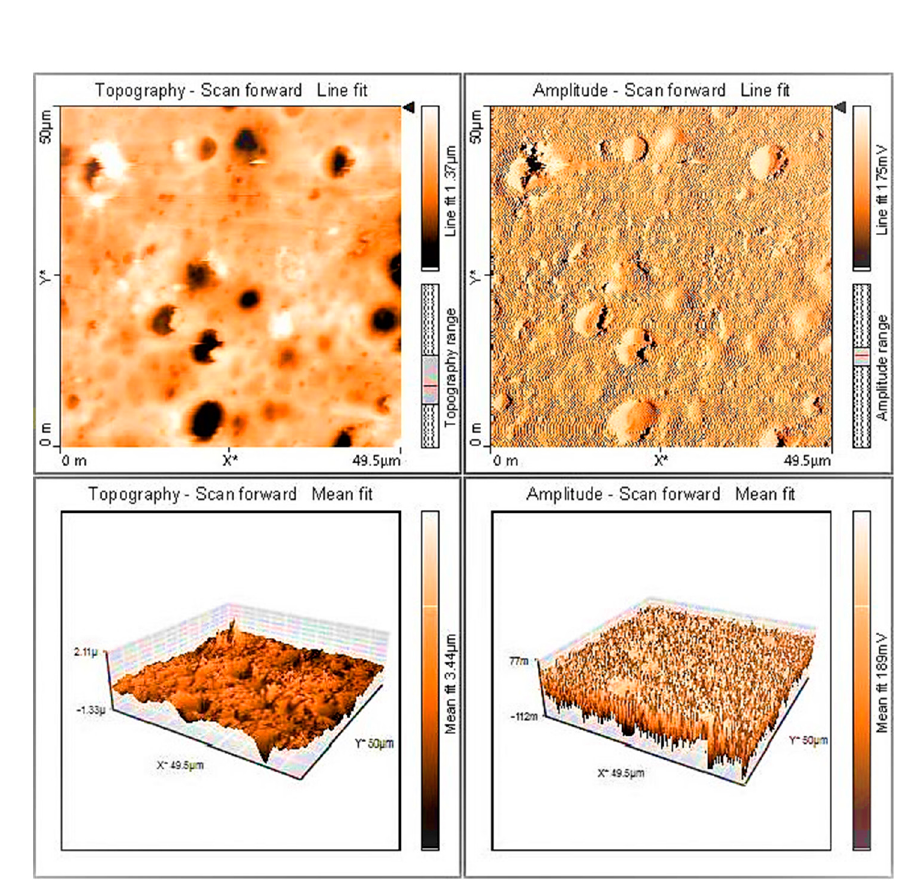
Figure 15. Two-dimensional (2D) and 3D AFM images of PVC containing polyphosphate 1 after